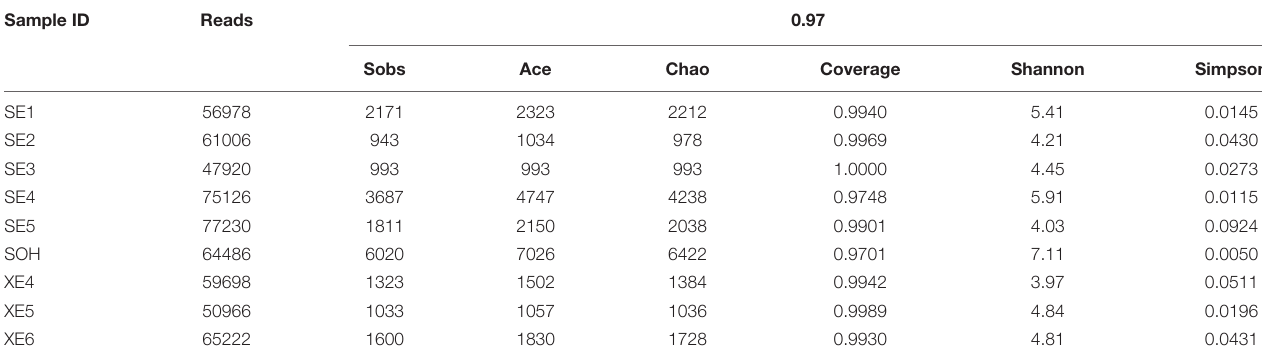
TABLE 1 | Number of sequences analyzed, OTUs, estimated community richness indices (Chao and Ace), coverage, and community diversity indices (Shannon and Simpson) of the 16S rRNA libraries of the corrosion samples. Sample ID